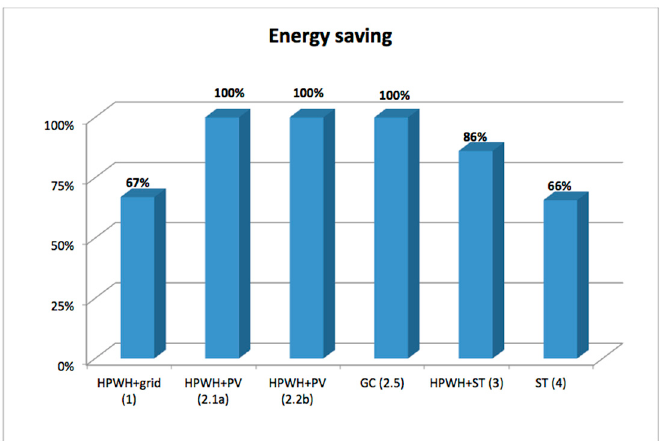
Figure 18. Comparison of the DHW energy saving.